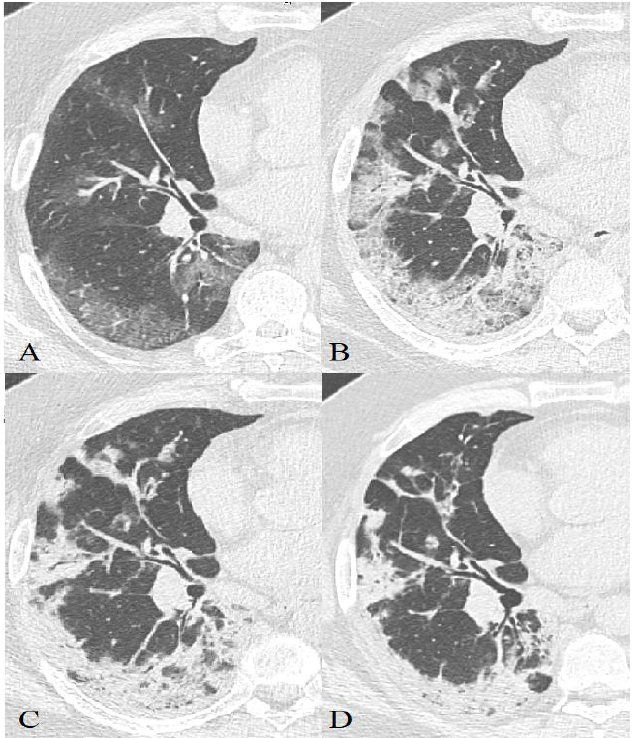
Figure 9. 57-year-old patient, m, 14.04 symptom onset, 21.04 PCR+, additional oxygenation for therapy, images obtained 21.04 ( A ), 27.04 ( B ), 30.04 ( C ), 07.05 ( D ), recovered.